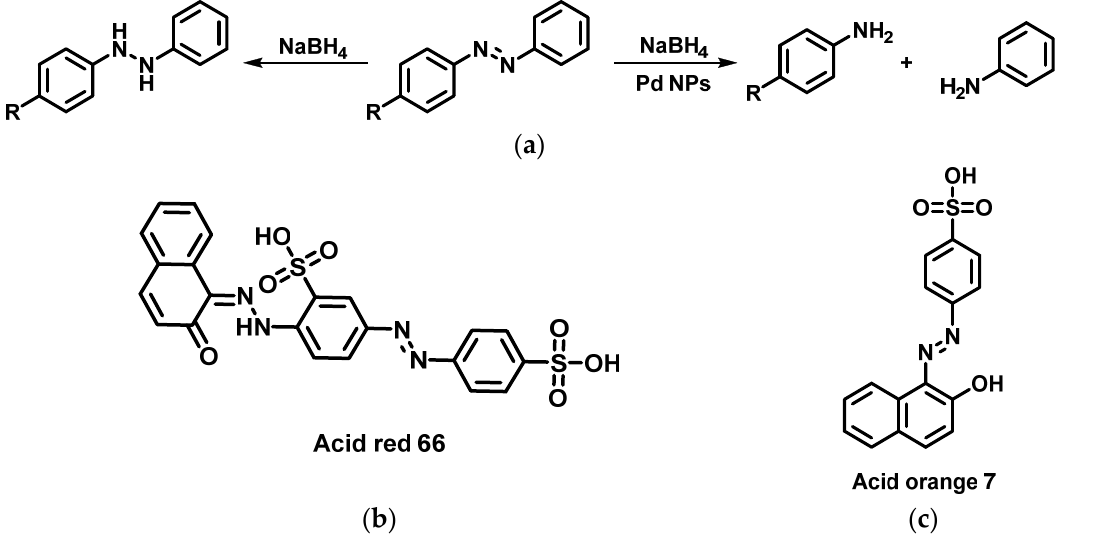
Figure 16. ( a ) Degradation of azo-dyes with and without Pd NPs and structure of acid red 66 ( b ) and acid orange 7 ( c )